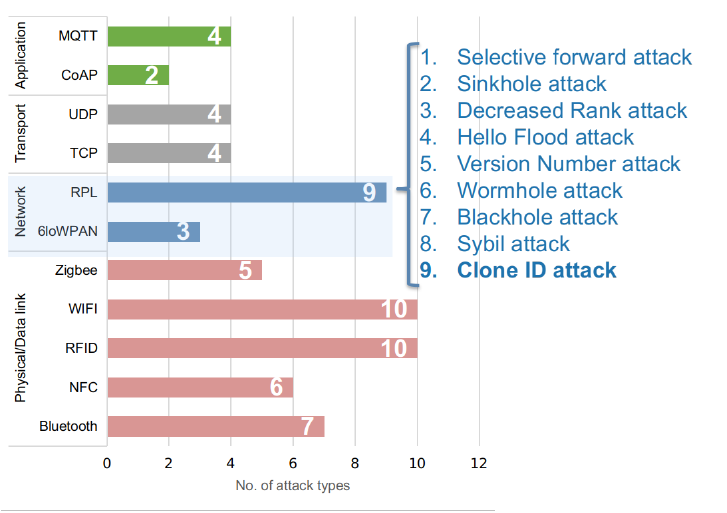
Figure 2. Number of cyber-attack types directed at IoT protocols, emphasizing those aimed at RPL and